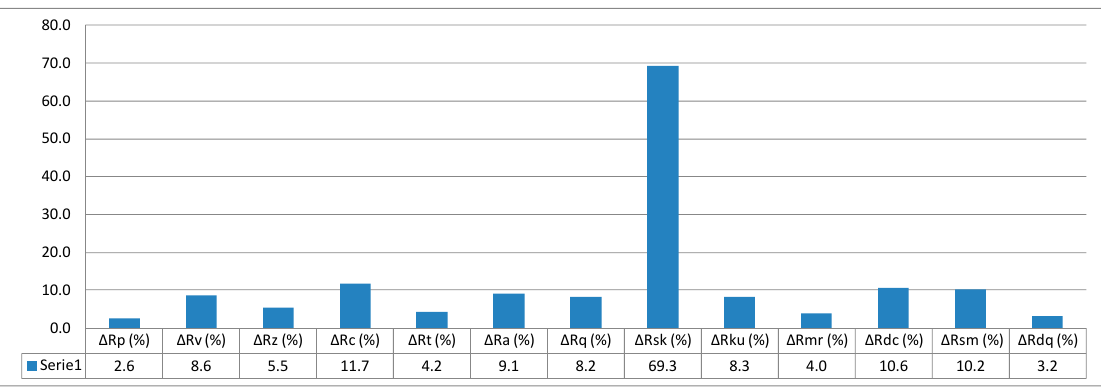
Figure 5. Relative values of surface parameters for printing orientation 0°.